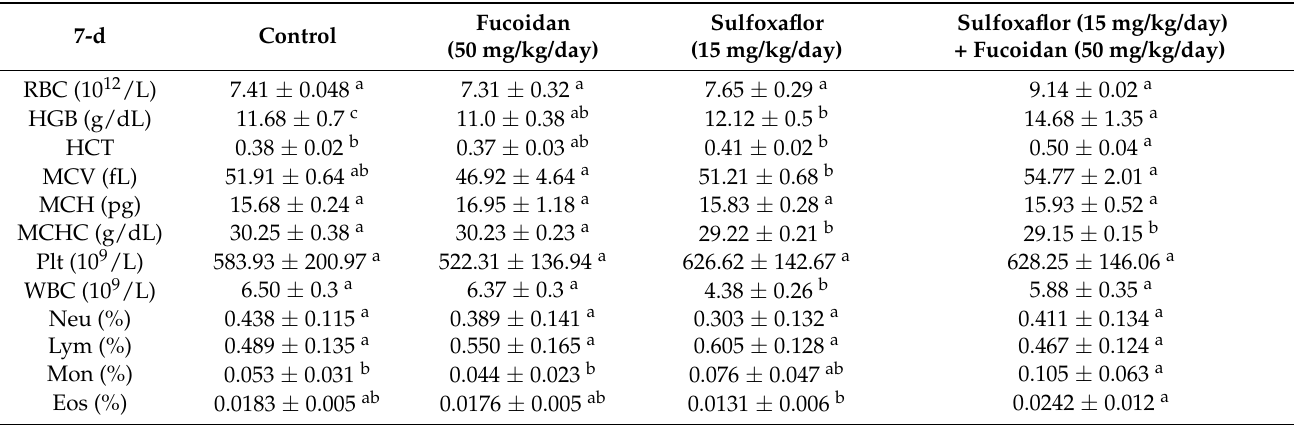
Table 2. Effects of sulfoxaflor and fucoidan on hematological parameters at 7-d treatment period in